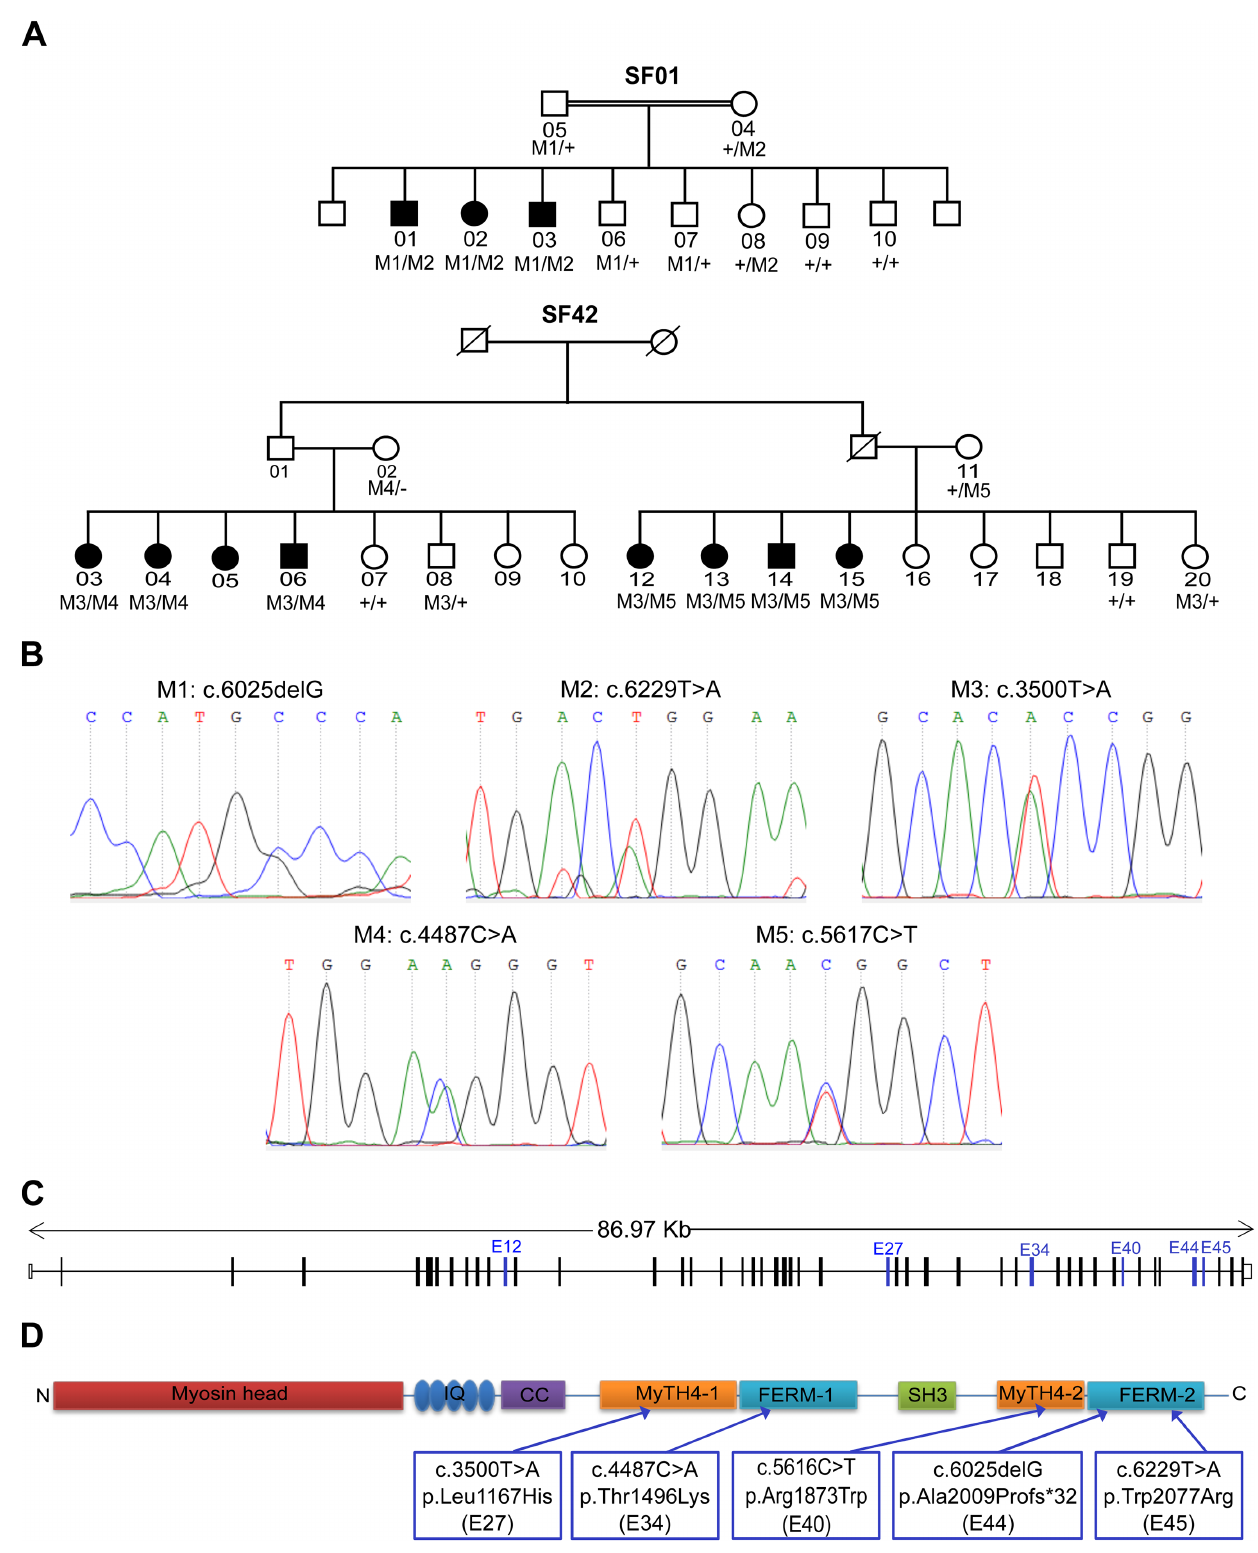
Fig 1. Molecular analysis of families SF01 and SF42 families. A: Pedigreesand genotypedata for each member of the SF01 and SF42 families: M1 to M5: mutation1to mutation 5. B: Electrophoregram presenting the MYO7A heterozygous mutations identifiedfor each family: